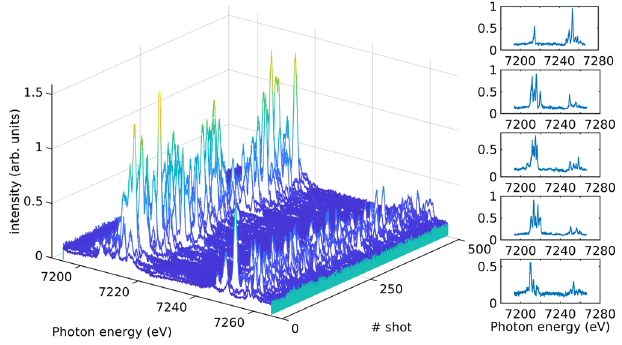
FIG. 4. Single-shot spectra for 500 consecutive shots, showing the generation of two-color FEL pulses. A few individual spectra are displayed separately on the right.